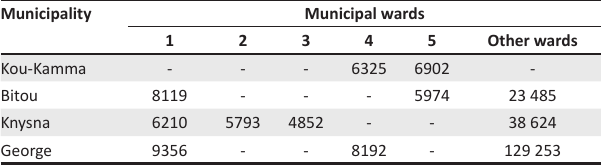
TABLE 1: Population numbers per ward for each of the local municipalities within the study area. Municipality